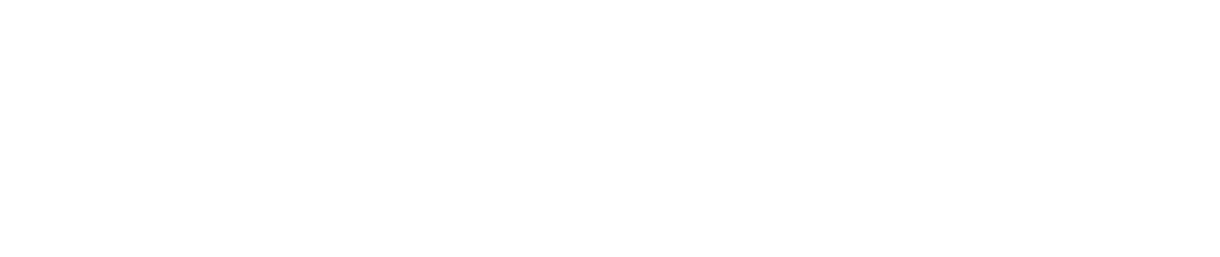
Frontiers in Plant Science | Plant Genetics and